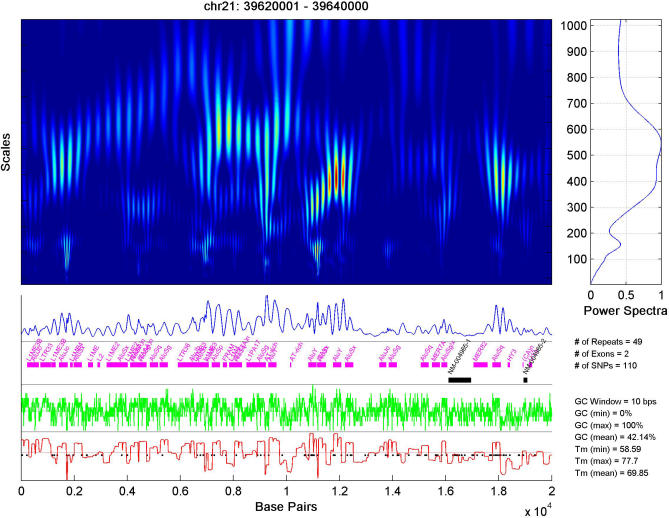
Local Spectral AnalysisLocal spectral analysis was performed on several randomly chosen 2-bp segments from various chromosomes. The segments were further divided into subsegments of 20 Kbp for which spectral analysis was performed individually. Wavelengths in the range of 2 bp to 1,024 bp, in steps of 2 bp, were assessed for each segment. This figure shows a representative segment (chr21: 39,620,001–39,640,000). The main part of the figure shows a heat map representation of the results from the spectral analysis. Below the main part, the power spectrum along the bases of the segment is displayed, followed by annotations of repeat structures and exons residing in the given segment. Below this again, the GC content profile (based on 10-p nonoverlapping windows), and then the melting map (as extracted from the corresponding region of the genomic melting map), are shown. The black dots in the melting curve represent the locations where known SNPs occur. On the right hand side, the power spectrum over the wavelengths is displayed; normalized to a value of 1 for the maximum.